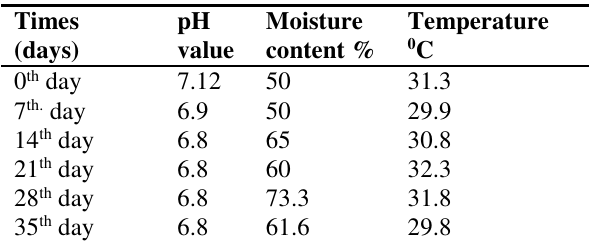
Fig. 4. Percentage of remaining diesel through remediation time in unamended soil